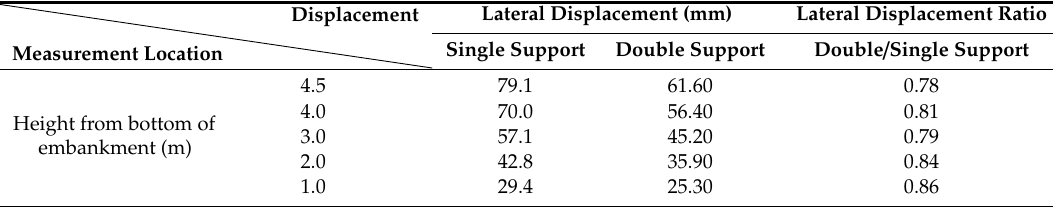
Table 2. Lateral displacement from a surcharge based on numerical analysis